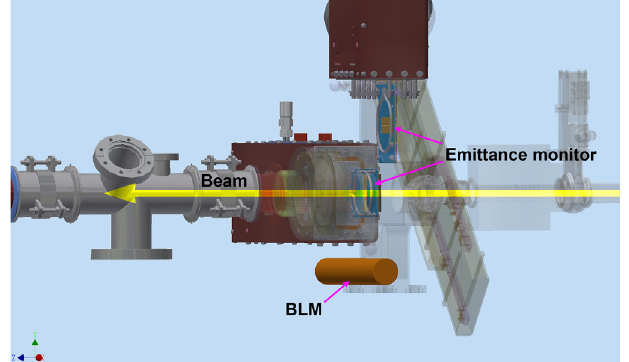
FIG. 14. The layout of the controlled beam loss experiment using an emittance monitor in the temporary beam diagnostic system of CSNS.